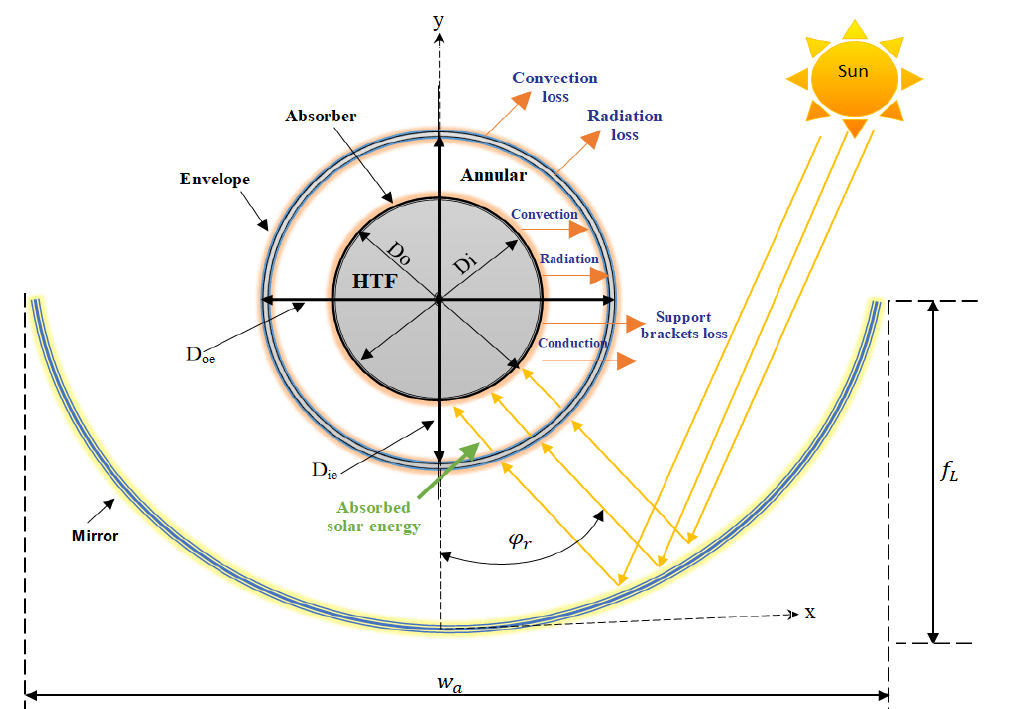
Figure 1. Schematic diagram of the parabolic trough and its receiver.